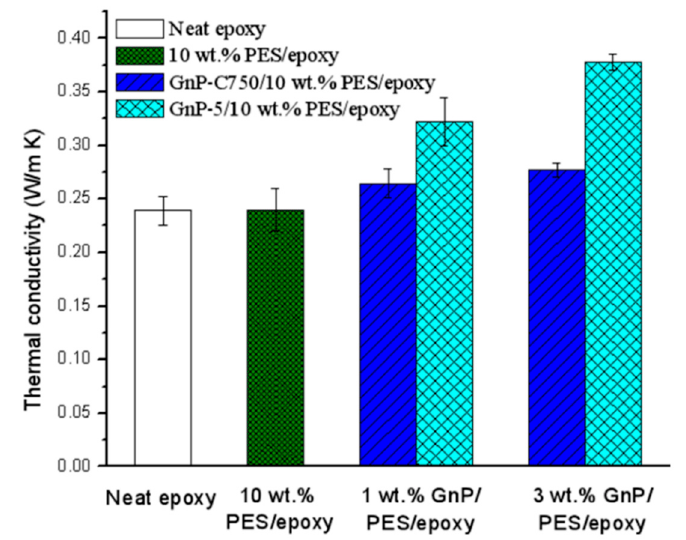
Figure 9. Thermal conductivity of epoxy-based composites.